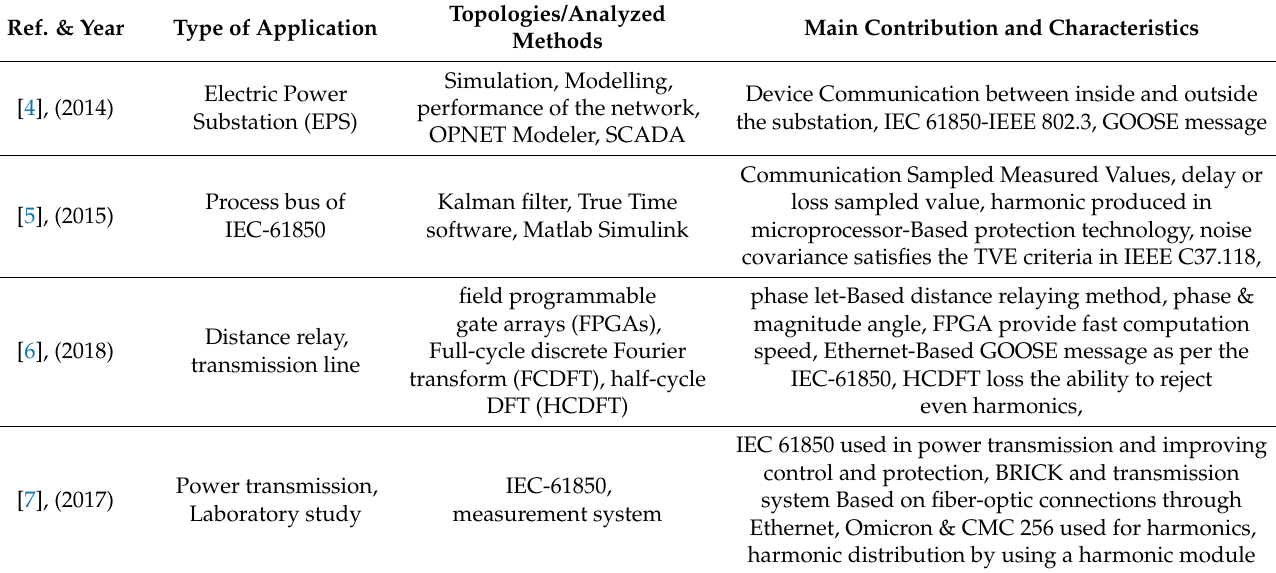
Table A1. Literature summary on harmonics detection &